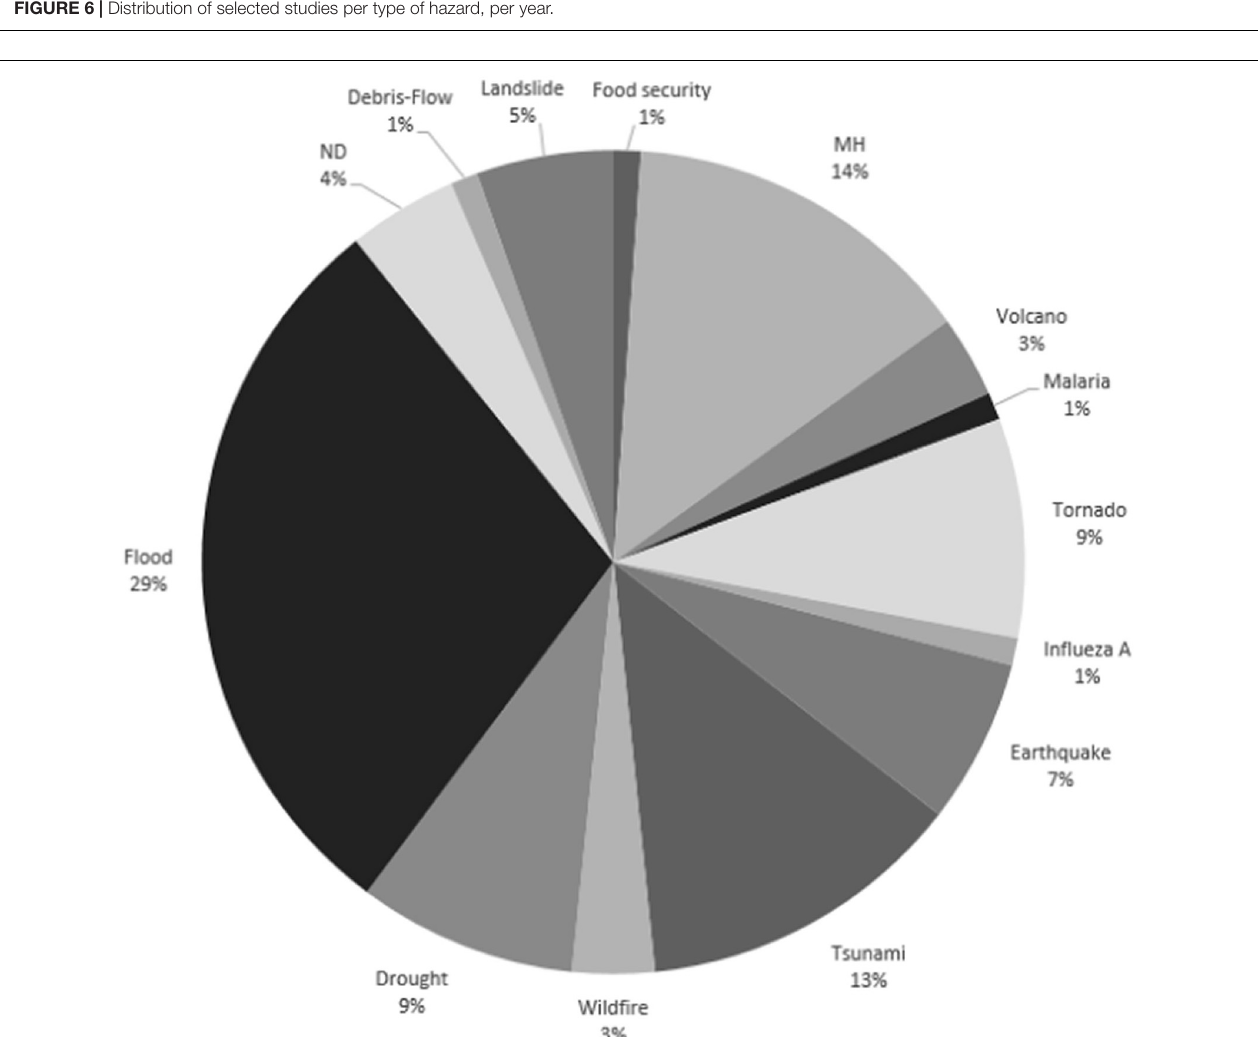
FIGURE 7 | Distribution of selected studies per type of